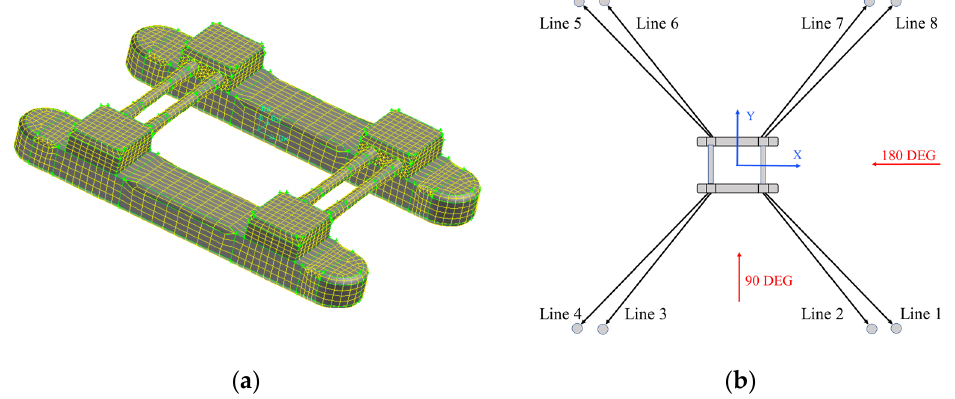
Figure 5. Schematic of semi-submersible platform and mooring system model. ( a ) Platform model; ( b ) schematic plan of mooring lines. Table 3. Main parameters of mooring lines. Table 2. Main characteristic of platform.